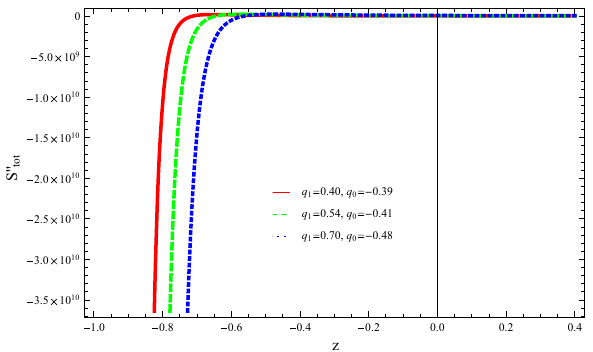
Fig. 9 Plotof w ef f versus z atHubblehorizonwithBekensteinentropy